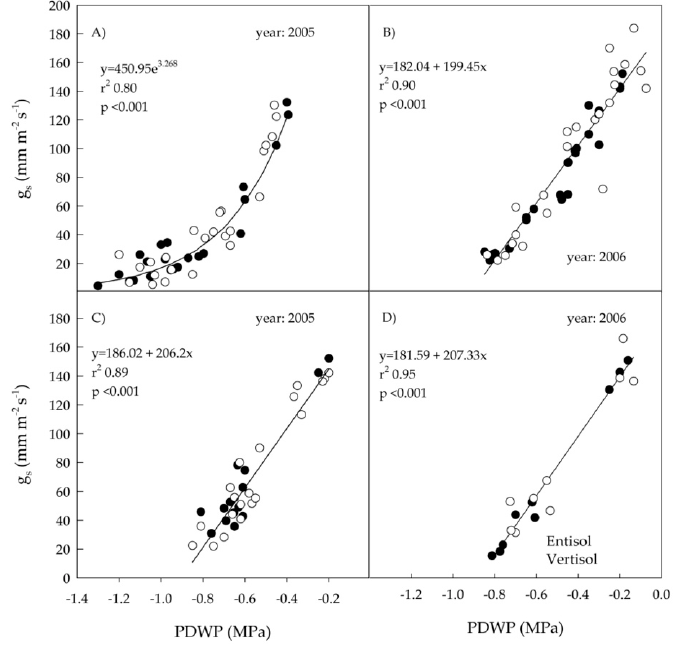
Figure 4. Relationships between stomatal conductance (g s ) and predawn leaf water potential (PDWP) of ‘Nero d’Avola’ vines grown in two soils (entisol and vertisol) under rain-fed conditions in 2005 ( A ) and 2006 ( B ), and under regulated deficit irrigation (RDI) in 2005 ( C ) and 2006 ( D ). Each point is the mean of four measurements. Data from the two soil types were similar ( t -test of coefficients, p < 0.05) and pooled together for each year and irrigation treatment.